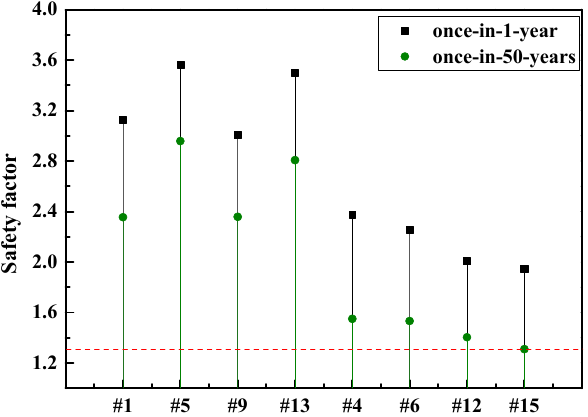
Figure 20. Safety factor of the mooring lines under extreme sea-states.